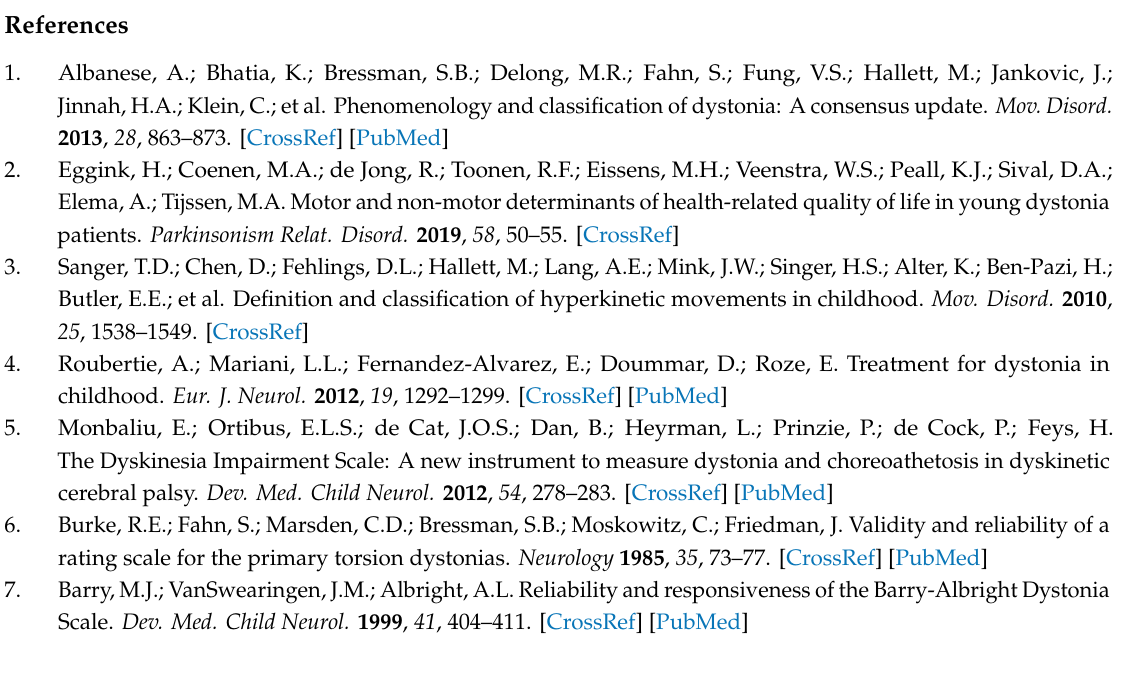
Supplementary material C, Table S1: Patient characteristics, Table S2: Genetic